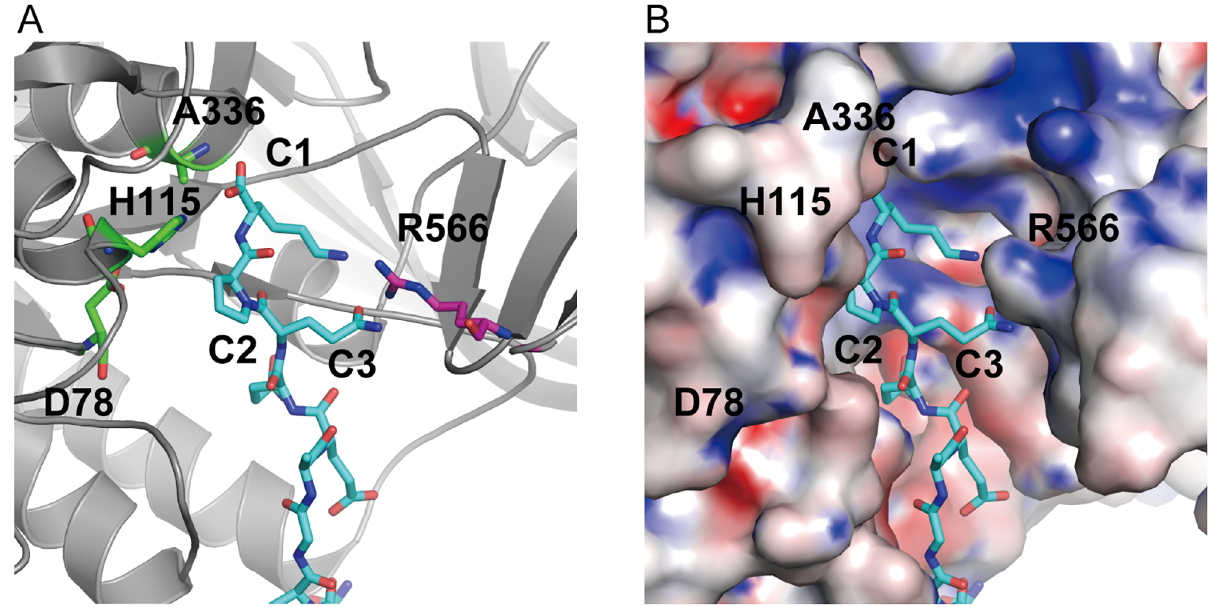
Fig 1. Close-up view of the interaction site of ASP(S336A) with ORF2. (A) To investigatethe interactionof ASP with ORF2, we incubatedthe inactive mutant ASP, ASP(S336A), with ORF2. After incubation with ORF2, the generatedcomplex of ASP(S336A) with ORF2 was purifiedand its complex structure was analyzed[17]. The structures of ASP and ORF2 are depictedby a ribbonmodel and a stick model, respectively. The positionsof the three amino acid residues of ORF2 (C1; Lys, C2; Pro, and C3; Gln residues which are the first, second and third amino acid residues from the carboxyl terminal end of the ORF2, respectively) and those of the four amino acid residues of ASP(S336A)(D78, H115, A336 and R566) are shown. D78, H115 and A336 are amino acid residues constitutingthe catalytic triad (in wild- type ASP, the amino acid residue at position 336 is S). (B) Electrostatic potential surface map of the catalytic regionof the complex of ASP (S336A) with ORF2. The locationof ORF2 is indicatedby stick model. The propertiesof severalamino acid residues shown in the figure are describedin the legendfor panel A. Negativelyand positivelychargedresidues are shown in red and blue, respectively.